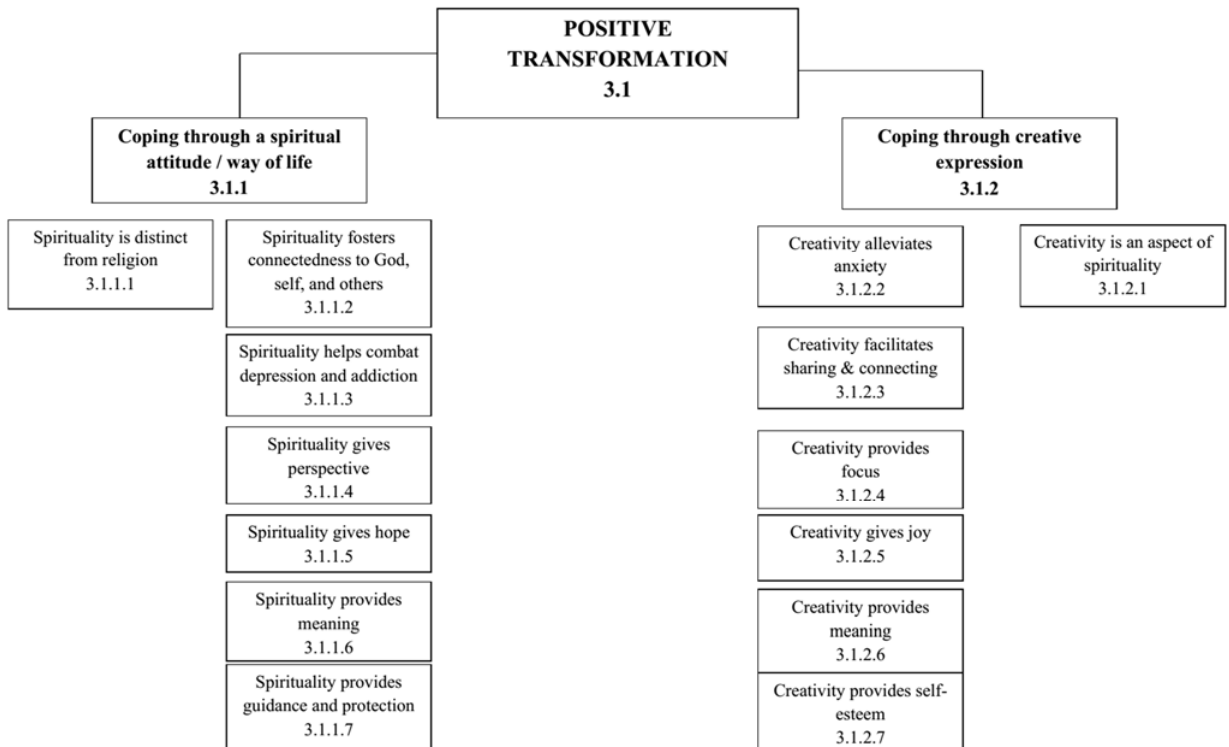
Figure 2. Theme structure for transformative